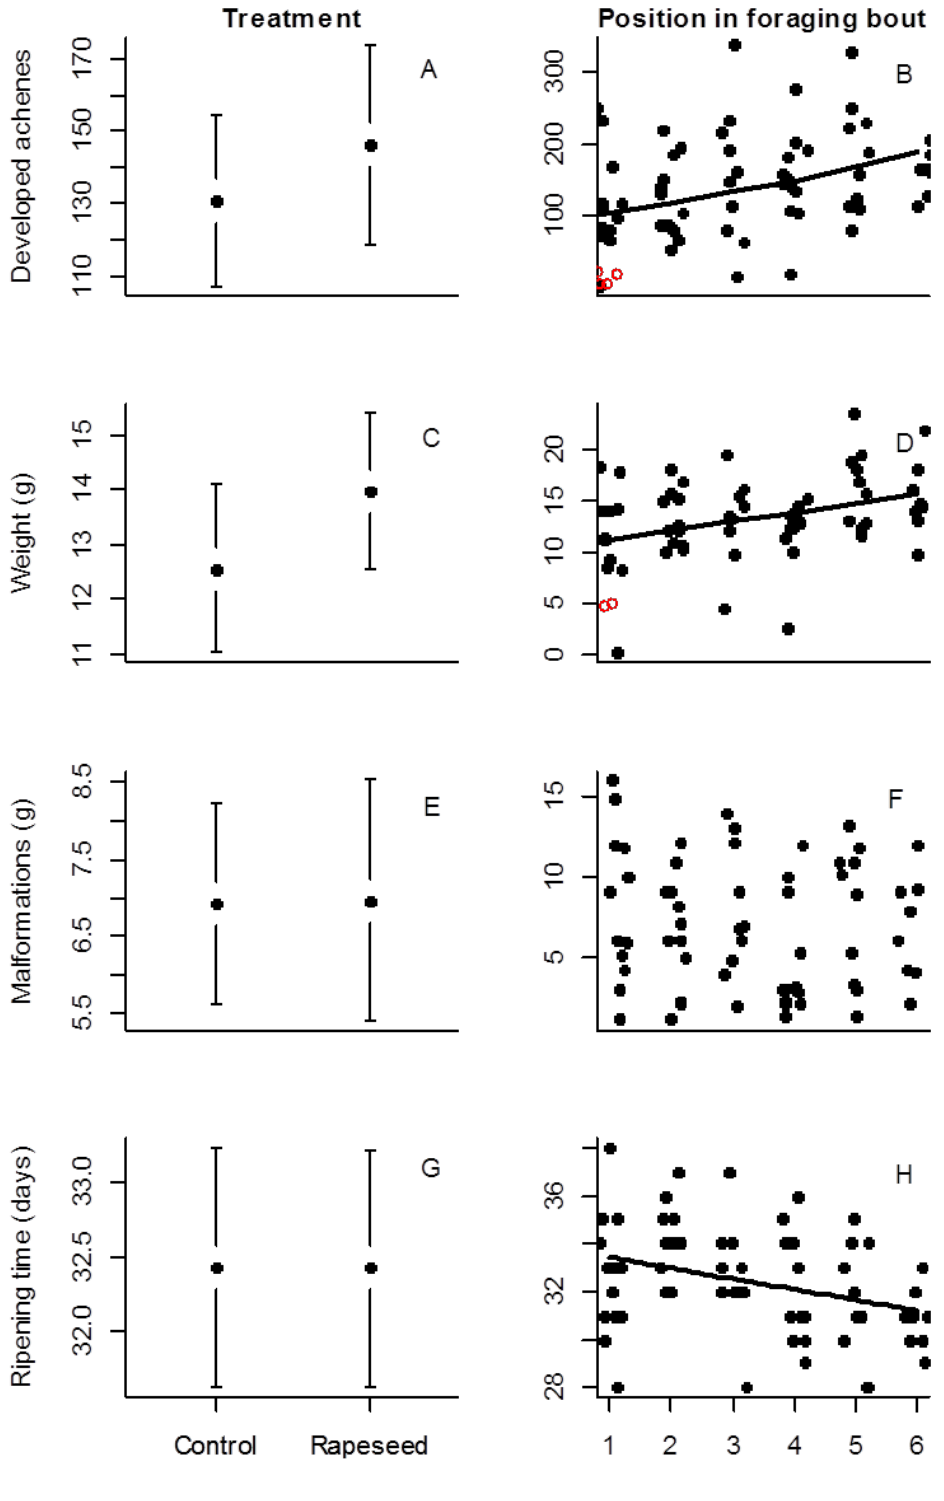
F IGURE 1. The panel shows (A,B) the number of developed achenes, (C,D) strawberry weight, (E,F) number of malformations and (G,H) ripening time in relation to (A,C,E,G) oilseed rape treatment and (B,D,F,H) the flower’s position in the simulated foraging bout. In the left column raw mean values for the two treatments are shown with error bars showing 95% confidence intervals. In the right column individual strawberries are shown in black and trend lines are added for significant effects. When accounting for the total number of achenes, the flower’s position in the foraging bout had a marginally non-significant effect on number of developed achenes (P = 0.056) and no effect on weight (P = 0.22). Strawberries that lacked data on the number of achenes, and consequentially were excluded from the latter analyses, are shown as red